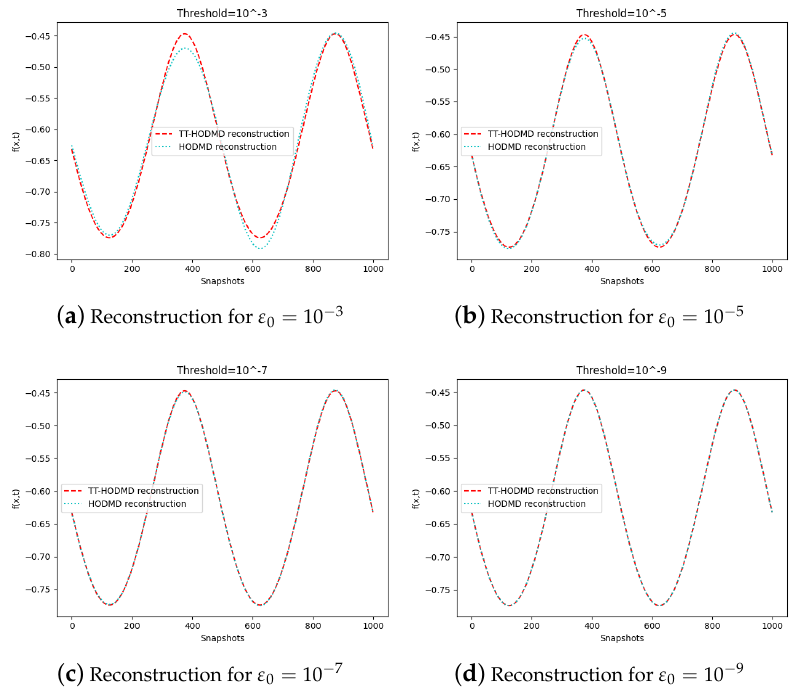
Figure 4. Reconstruction by TT-HODMD and HODMD with different thresholds.